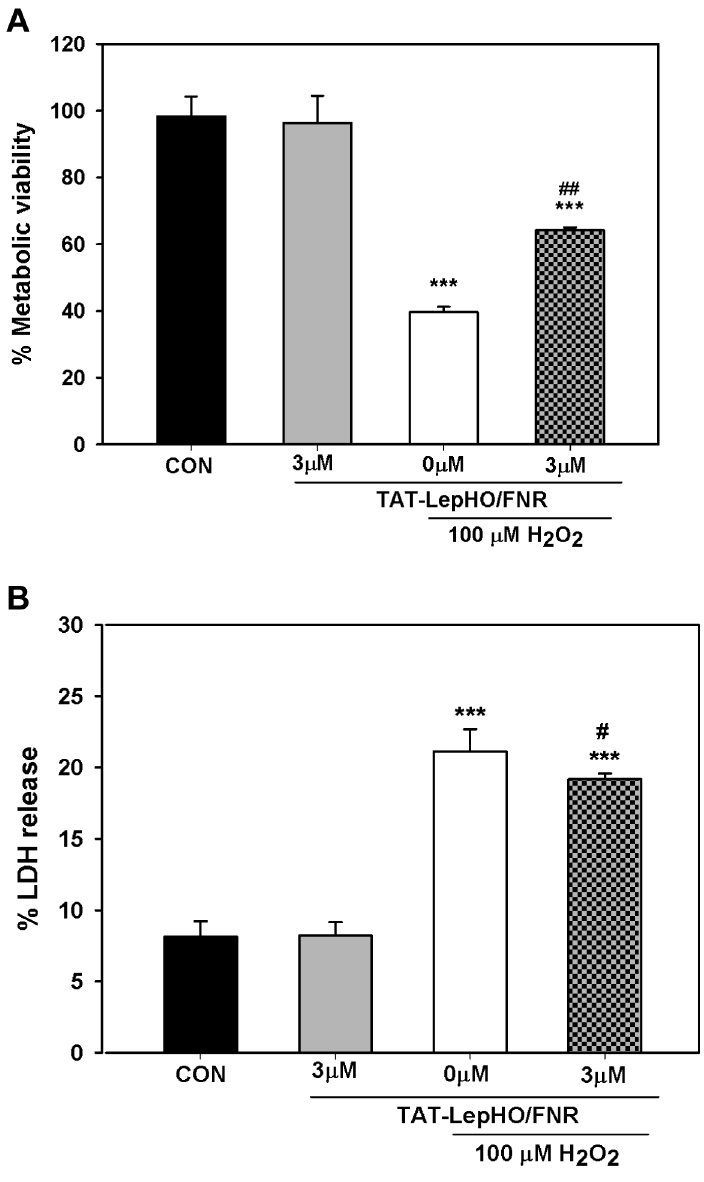
Fig 8. Rescue of cell viability after H 2 O 2 exposure mediated by TAT-fused protein delivery. SH-SY5Y cells were exposedto 100 μ M H 2 O 2 and treated with TAT-LepHO and TAT-LepFNR, as describedin Material and methods. Cell viabilitywas measuredas follows: (A) Metabolicviability. Culturemedia was replacedwith 100 μ L MTT solutionand after 4 h, the formazan crystal produced was dissolvedin DMSO and absorptionat 540 nm was determined.Cell viabilitywas expressedas percentage of control cells MTT reduction, n = 3. *** p < 0.001vs. CON (control) cells; ## p < 0.01 vs. H 2 O 2 alone treated cells. (B) LDH release.Aliquots of